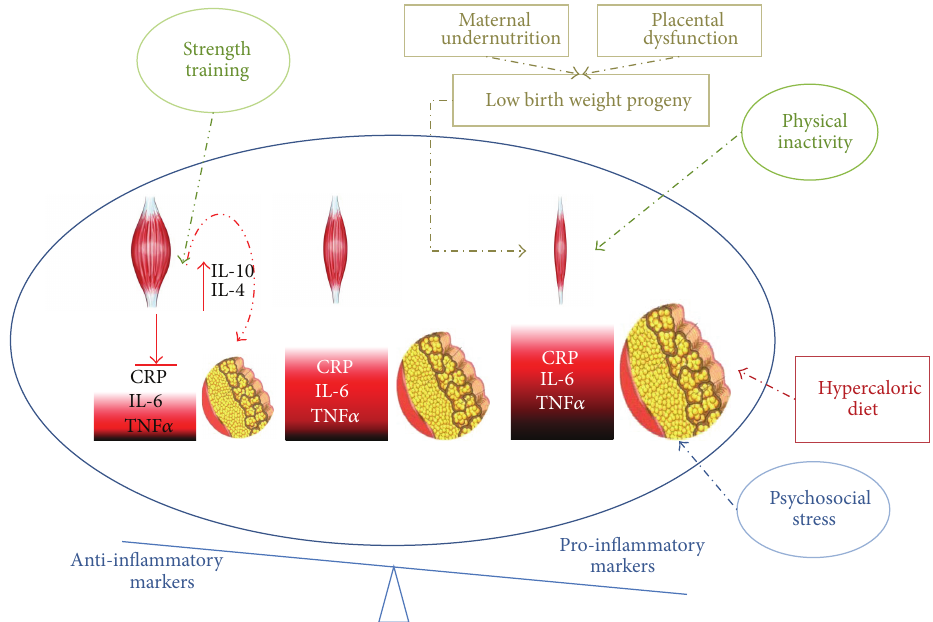
Figure 1: The opposing influences of muscle mass and fat mass on the pro-inflammatory : anti-inflammatory balance. The middle condition shows normal muscle mass and fat mass. The condition on the right shows the impact of low birth weight and lower muscle mass/strength interacting with lifestyle influences such as inactivity, which also promotes lower muscle mass/strength and hypercaloric diets, promoting increased fat mass. Larger fat mass stimulates pro-inflammatory adipokine release and reduces anti-inflammatory adipokine release, while lower muscle mass/strength and lower physical activity are associated with higher pro-inflammatory adipokine and lower anti-inflammatory myokine release, respectively. To the left is the condition whereby the influence of strength training stimulates muscle mass/strength, associated with a lower inflammatory burden and which also promotes the secretion of anti-inflammatory myokines such as IL-4 and